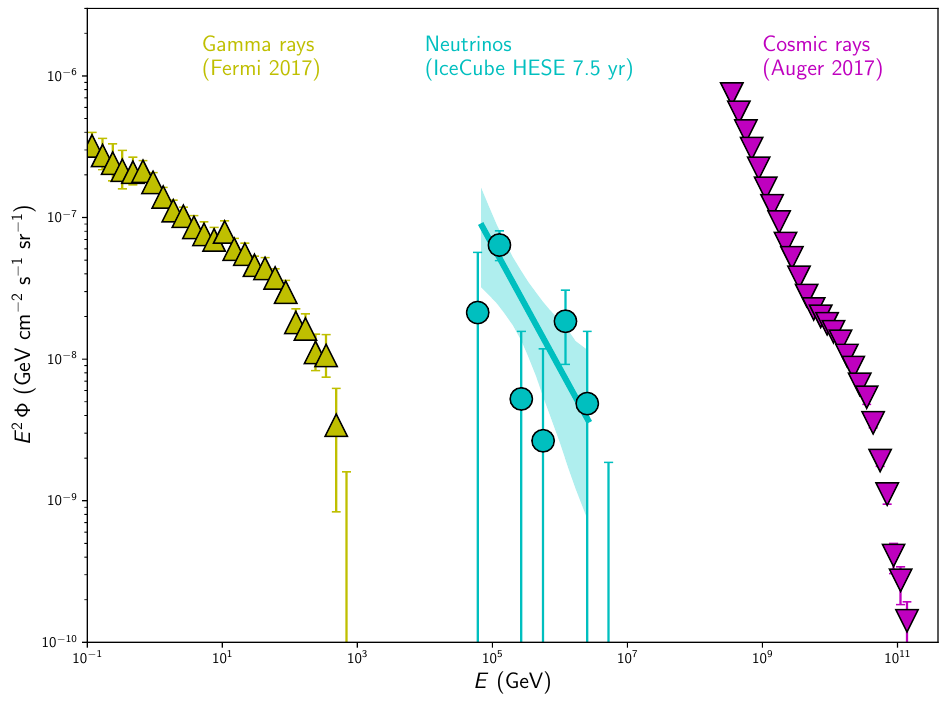
Figure 3. High-energy fluxes of gamma rays [66], neutrinos [67], and cosmic rays [68]. Figure adapted from the work in